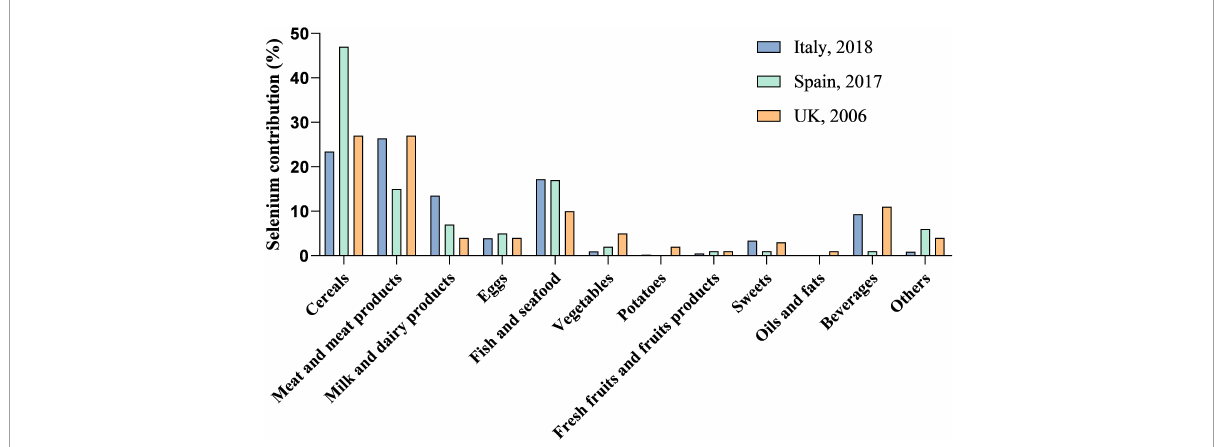
FIGURE1 Selenium contribution to total dietary selenium intake. Data for selenium contribution to total dietary selenium intake are adapted from published studies. Diet is the main source of selenium for human beings. The species of food, selenium content in food, as well as the amount taken in diet affect the daily selenium intake and selenium status.